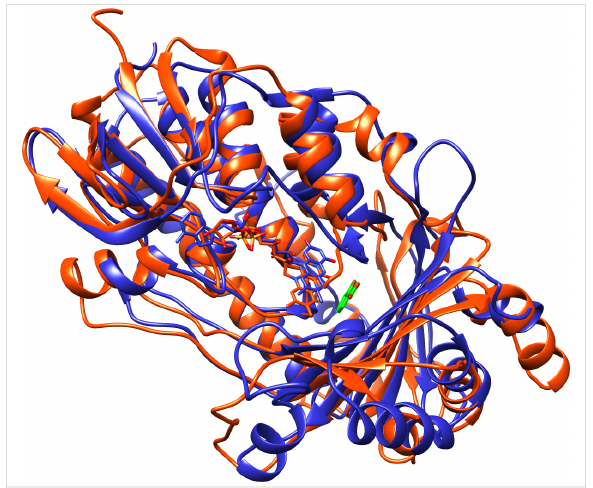
Figure 3: Overlay of structures of salicylate hydroxylase (orange, pdb file 5evy) and 2,3-dihydroxypyridine 3-hydroxylase (blue, pdb file 2vou). The salicylate bound to the latter is shown in